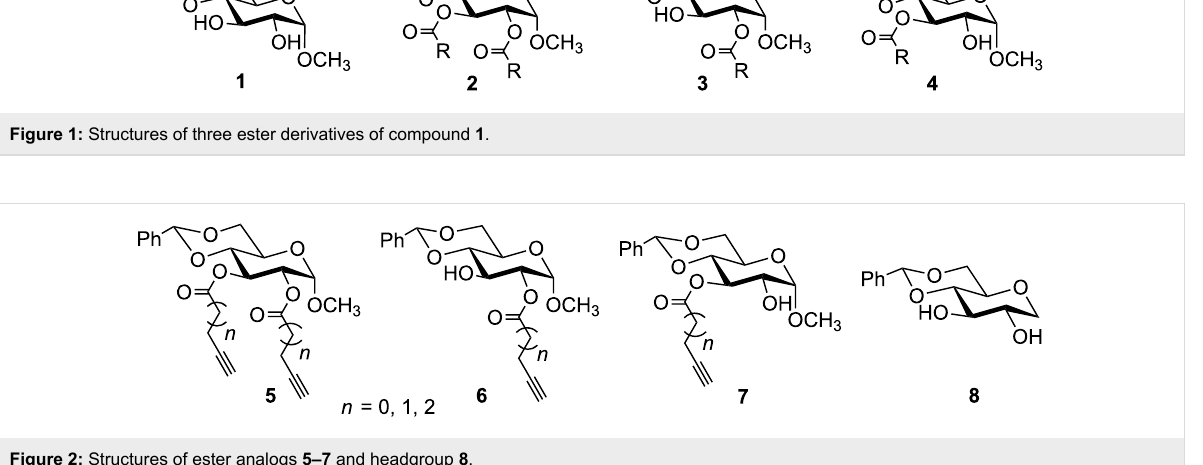
Figure 2: Structures of ester analogs 5–7 and headgroup 8